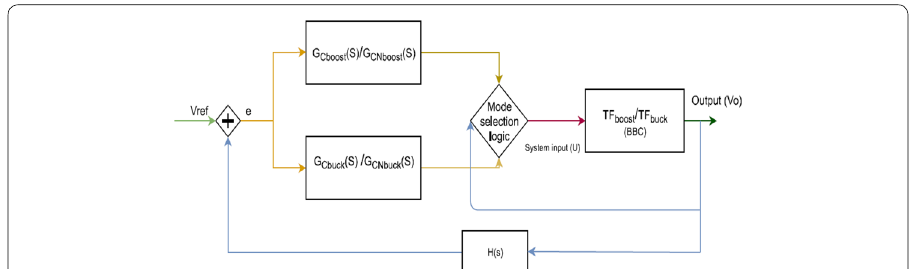
Fig. 4 Analog closed-loop control model of bidirectional buck–boost converter with PID and PIDN control